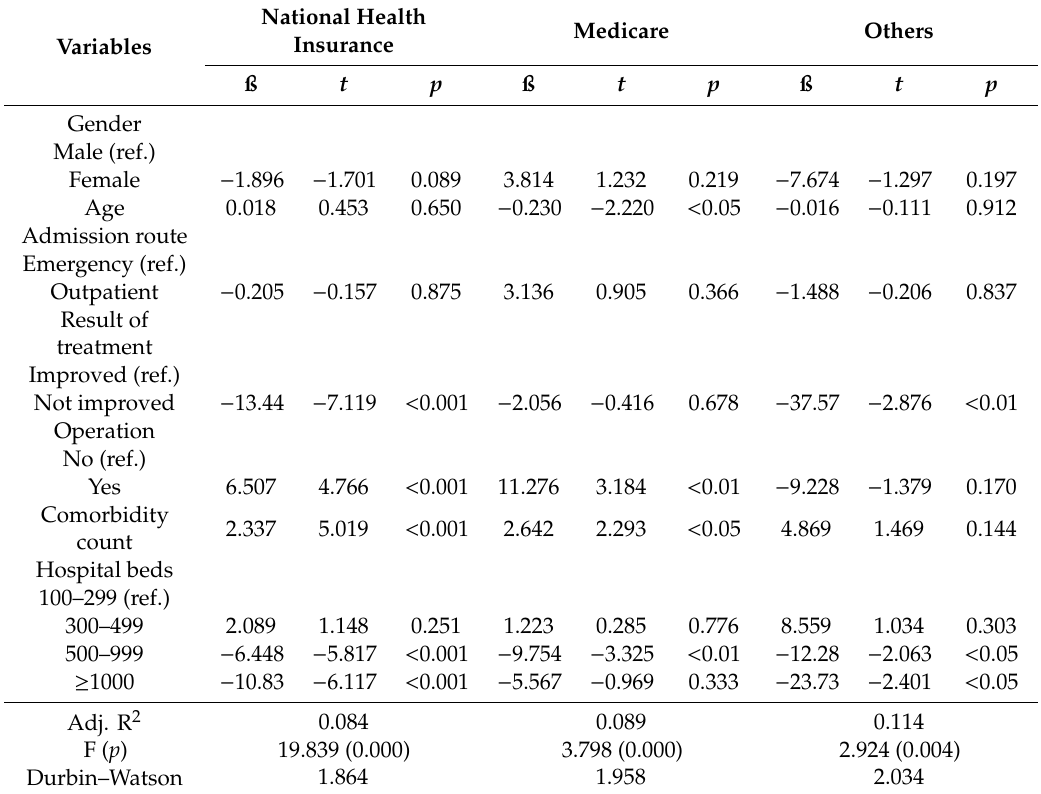
Table 4. Factors associated with the length of stay for hip fracture